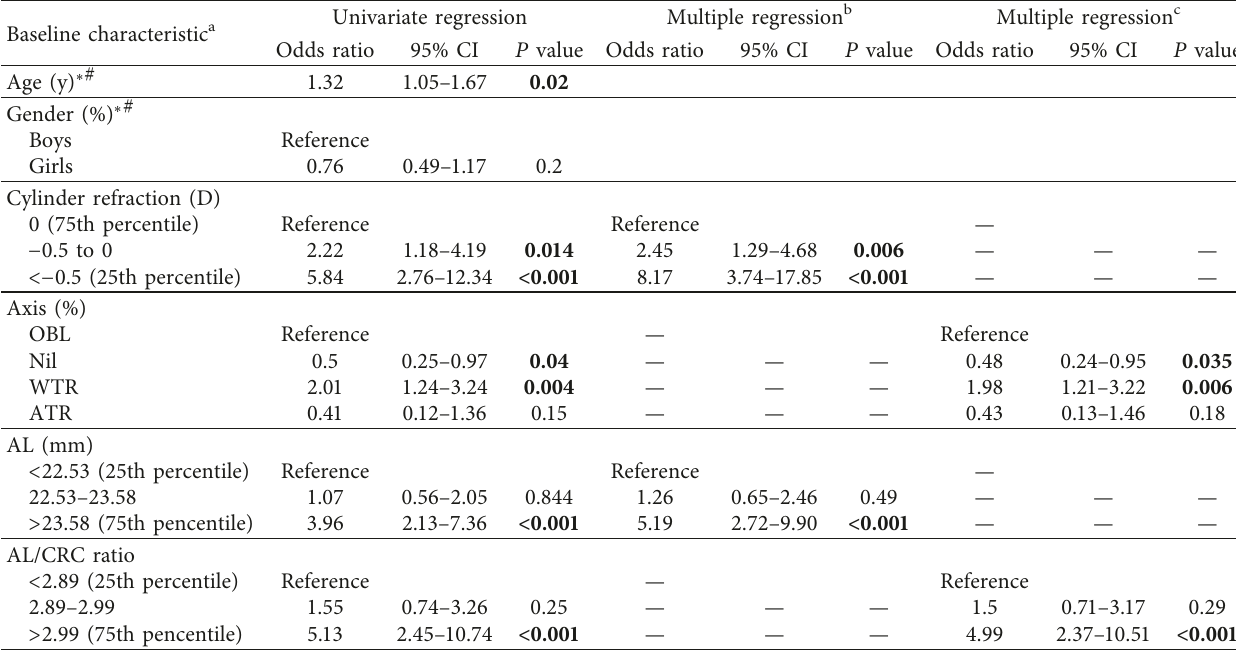
Table 3: Logistic regressions of baseline factors for development of CSA from non-CSA eyes after two years. Baseline characteristic a